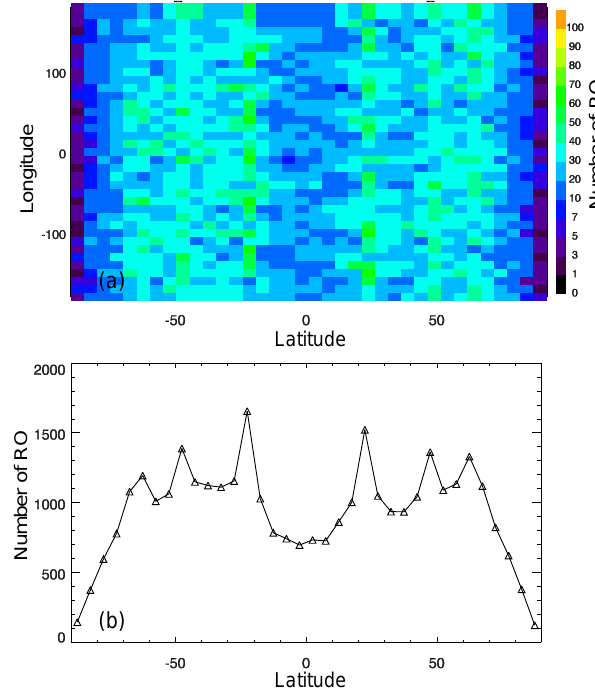
Figure 1. (a) Number of METOP-A and B radio occultations per 5 ◦ latitude and 10 ◦ longitude bin in June 2015. The total number of oc- cultations in this month is about 35000. (b) Number of occultations per 5 ◦ latitude bin integrated over all